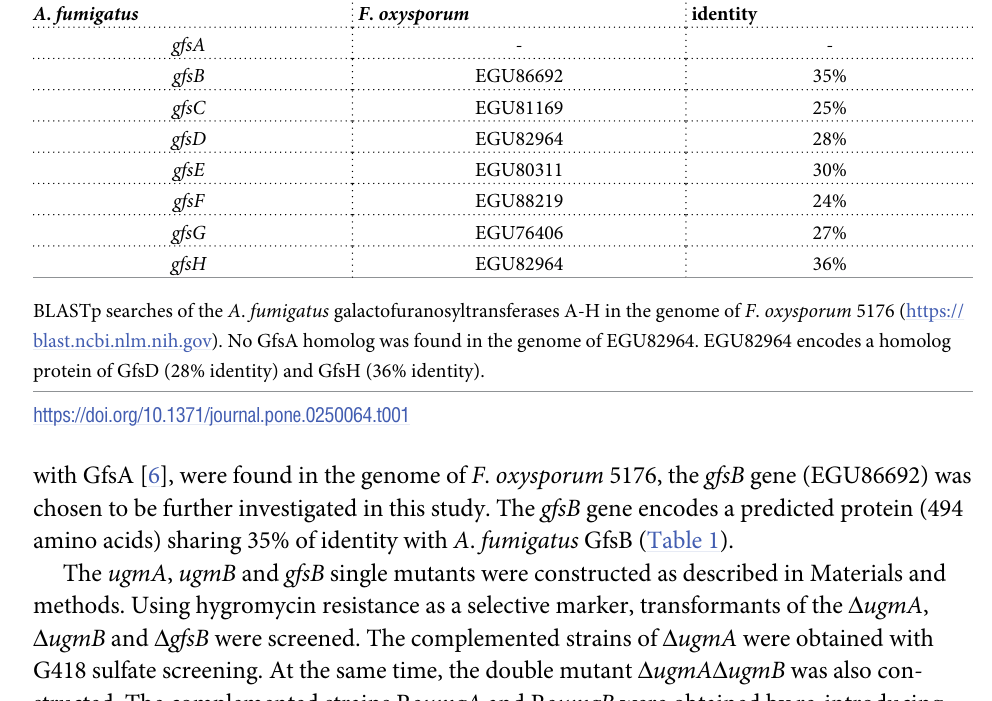
Table 1. Identification of Gal f -tansferases in F . oxysporum .